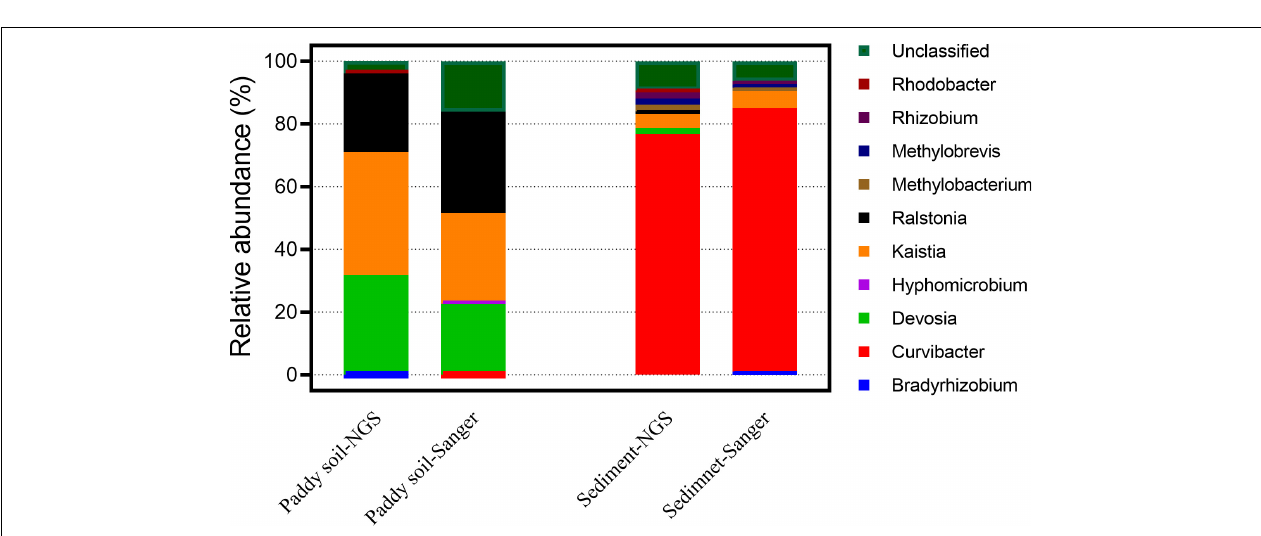
FIGURE 2 | The taxonomic comparison of Miseq (NGS) and clone (Sanger) sequencing of aioA genes in paddy soil and sediment samples using 1109F/1548R primers.